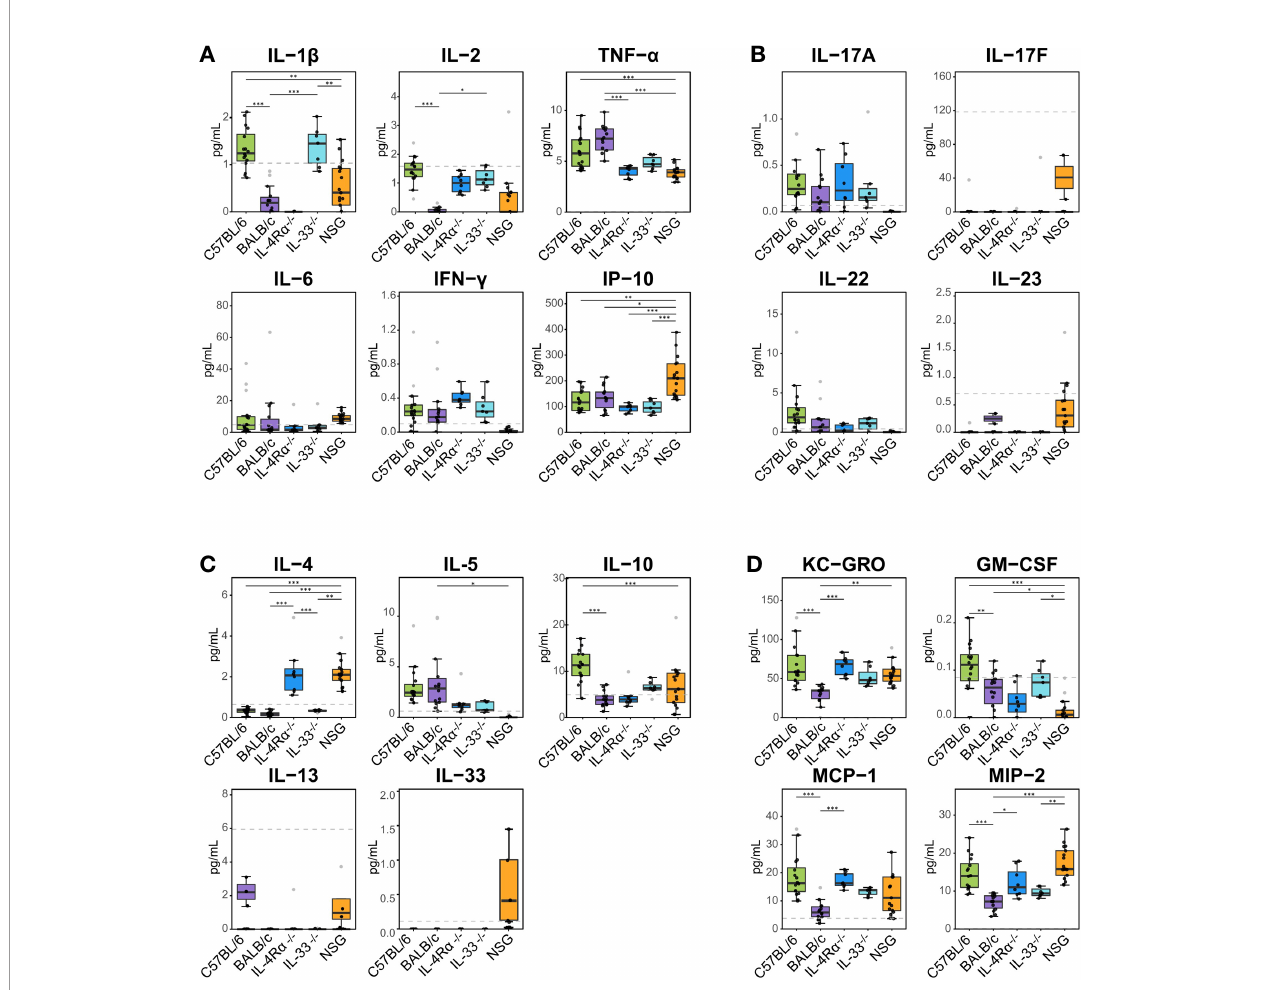
FIGURE 2 | Plasma cytokine, chemokine, and growth factor (CCG) levels in naïve immunocompetent and immunode fi cient mice show immune polarizations. Plasma cytokine levels were measured with multiplexed cytokine assays in SPF-housed wild-type C57BL/6 (n = 16, green) and BALB/c (n = 14, purple), Th2-de fi cient IL-4R a -/- (n = 9, blue) and IL-33 -/- (n = 7, light blue), and Th1/Th2-de fi cient NSG (n = 18, orange) animals. Cytokines were studied as (A) pro-in fl ammatory Th1, (B) pro-in fl ammatory Th17, (C) anti-in fl ammatory Th2, and (D) immunomodulatory and other growth factors. Naïve C57BL/6 animals are Th1-leaning compared to BALB/c mice due to higher levels of e.g., IL-2, IL-1 b , and immunomodulatory IL-10. Similarly, naïve Th2-de fi cient animals are also Th1 leaning displaying higher levels of IL-2, KC-GRO, MCP-1, and MIP-2 compared to wild-type BALB/c mice. Dashed lines indicate limit of detection. Normality was assessed with Levene ’ s test, followed by parametric ANOVA or non-parametric Kruskal-Wallis tests as indicated. Box plots indicate median (middle line), 25th, 75th percentiles (box), and 5th and 95th percentiles (whiskers) as well as outliers (single gray dots). Only signi fi cances from main comparisons as described in the results section are shown. * P < 0.05. ** P < 0.01. *** P <